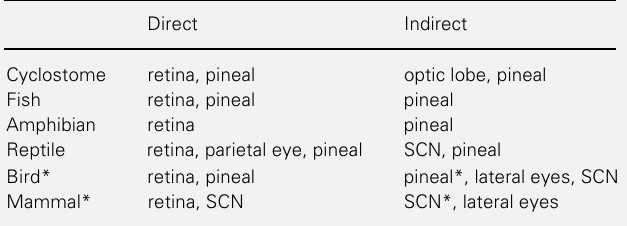
Table 1 - Structures of the vertebrate brain in which the presence of circadian oscillators has been demonstrated by in vitro experiments (di- rect) or by lesion, transplant or other (indirect) techniques. *Indicates classes and organs in which data on transplant are